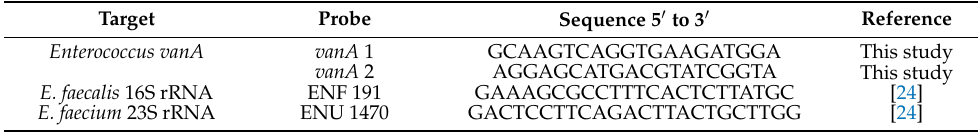
Figure 1. Comparison of a biofilm assay on a coverslip with the Gene Frame ® apparatus (GFA) applied to E. faecalis MF04010. All biofilms were grown for 24 h at 37 ◦ C under static growth conditions. ( a , b ) 40 × micrographs of the coverslip method ( a ) and the Gene Frame ( b ). ( c , d ) 40 × phase contrast micrographs ( c ), highlighting free-floating, detached biofilm masses that occurred when processed for microscopic visualisation ( d ). The Gene Frame method generated minimal biofilm surface detachment. ( e , f ) 100 × micrographs imaged with fluorescence and Hoechst DNA staining (blue) (panels e , f ). The coverslip method ( e ) dislodged large quantities of cells into the planktonic phase through processing. The gene frame ( f ) minimised this phenomenon. Scale bar for images ( a – d ) represents 50 microns. Scale bar for ( e , f ) represents ten microns. Table 2. Probes used for fluorescent in situ hybridisation